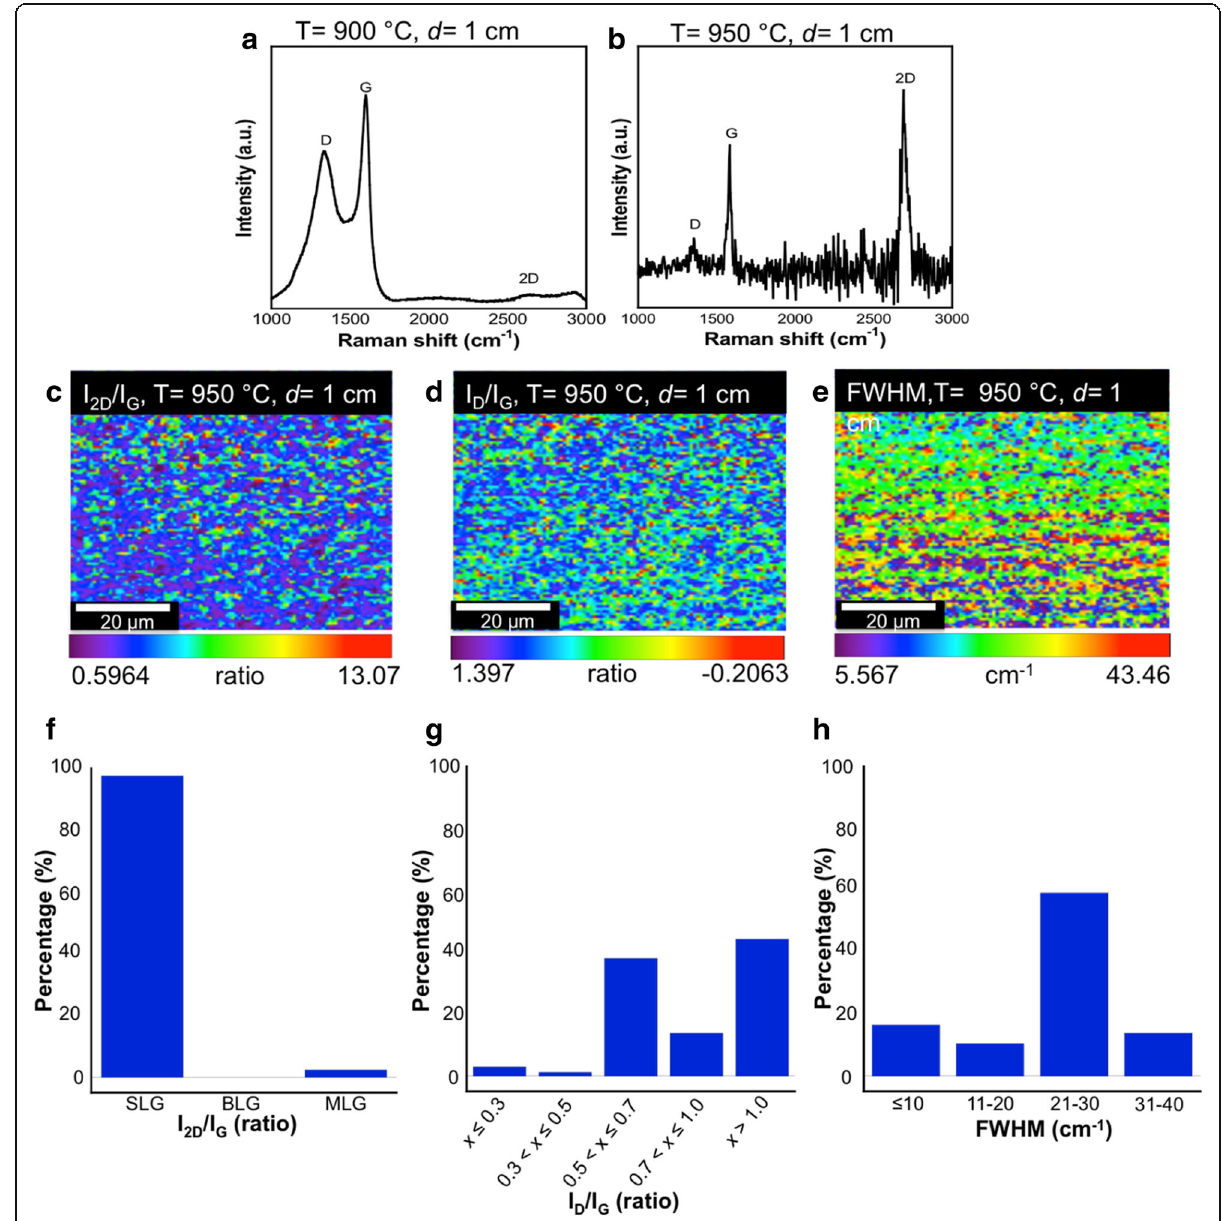
Fig. 6 Single Raman spectrum for the sample grown at temperatures of a 900 °C and b 950 °C. Raman mapping images of sample grown on Cu substrate at temperature of 950 °C for c I 2D / I G , d I D / I G , and e FWHM value of 2D band. Also, the histograms to indicate the distribution percentage of the intensity ratio, f I 2D / I G , g I D / I G , and h FWHM value of 2D band. A distance between nozzle and substrate is 1